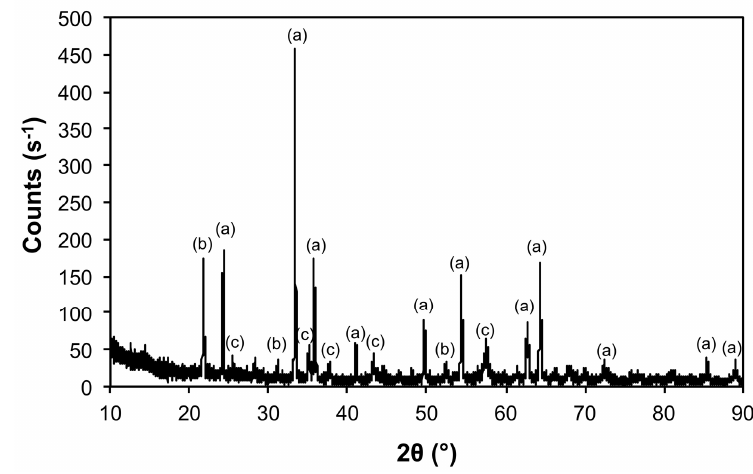
Figure 3. X-ray diffraction (XRD) of the product from the thermal decomposition of 1 under air at 1100 ◦ C (Air@1100) with crystalline phases (Table 3) indicated: (a) Fe 2 O 3 , (b) Al(PO 4 ), and (c) Al 2 O 3 . Table 3. Summary of crystalline phases detected by XRD and crystallite size, determine from the Scherer equation. Sample Phase